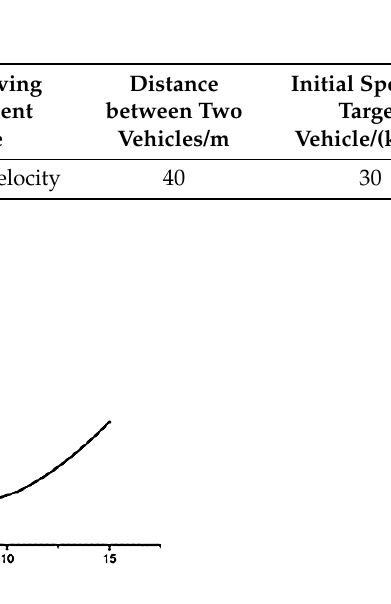
Figure 10. Relative distance between two vehicles in CCRm test.